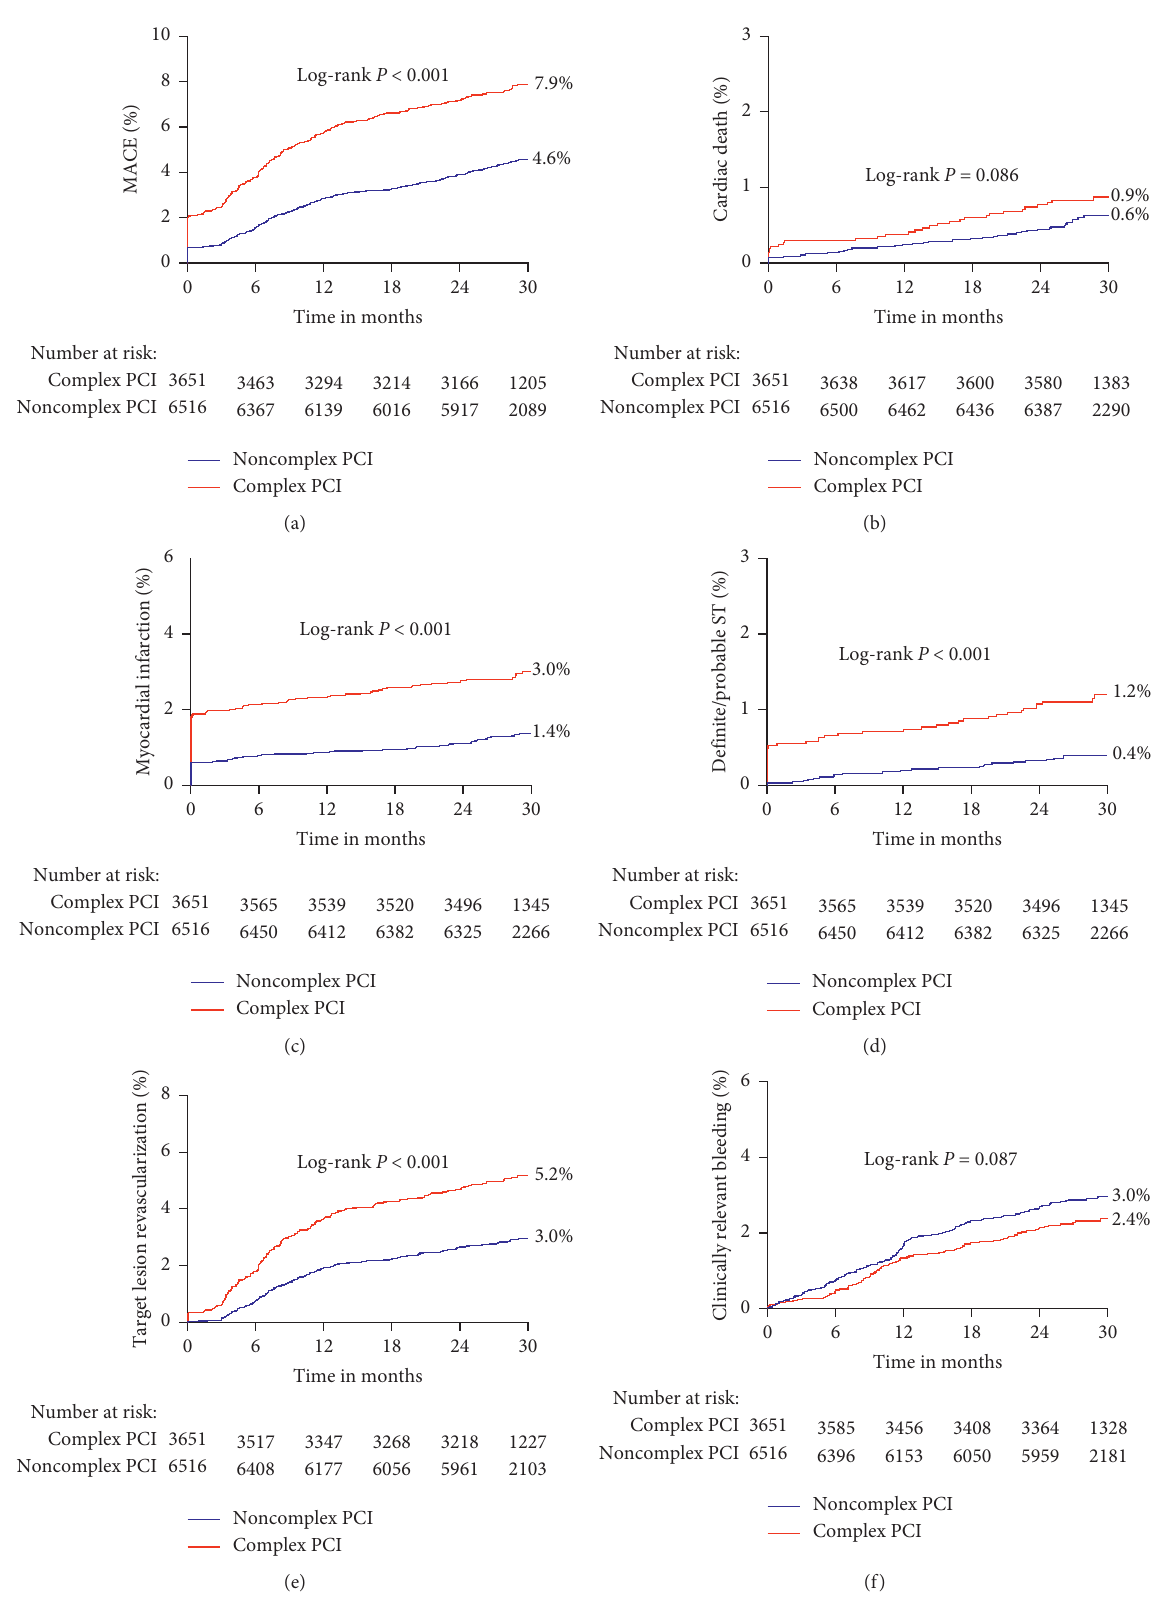
Figure 1: Kaplan–Meier cumulative event curves for (a) major adverse cardiovascular events (MACE), (b) cardiac death, (c) myocardial infarction (MI), (d) definite/probable stent thrombosis (ST), (e) target lesion revascularization (TLR), and (f) clinically relevant bleeding according to PCI